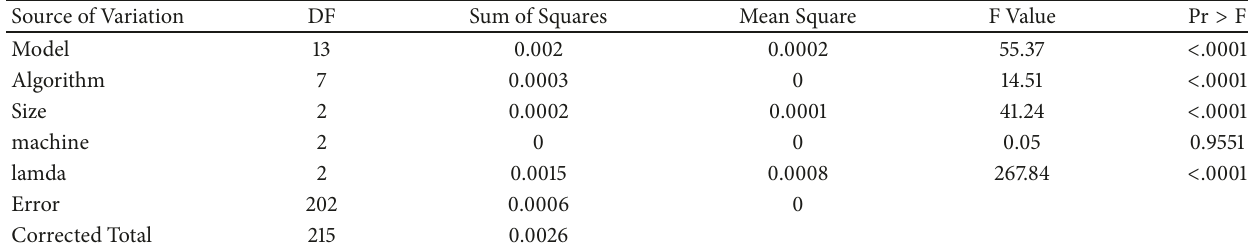
Table 6: ANOVA for the AEP for small number of orders.